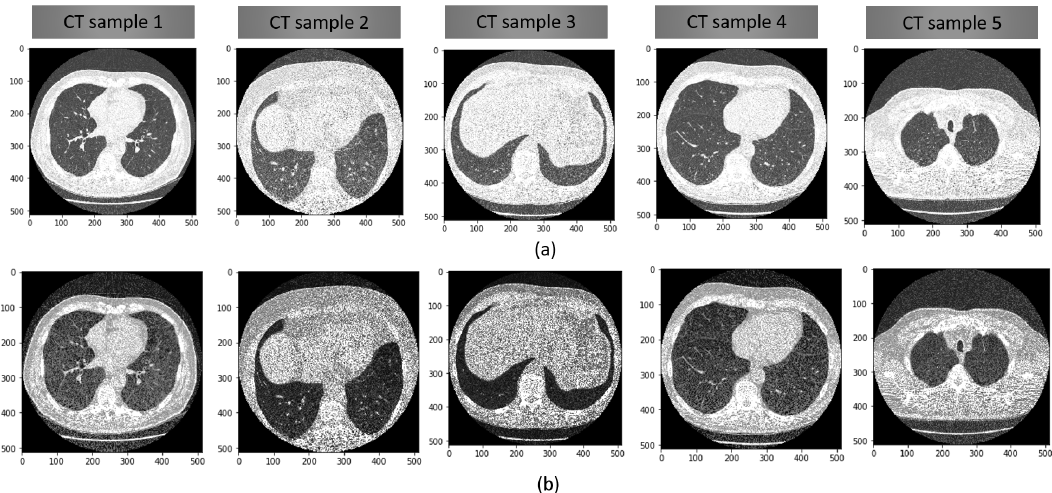
Figure 2. Results of pre-processed image and the original lung CT